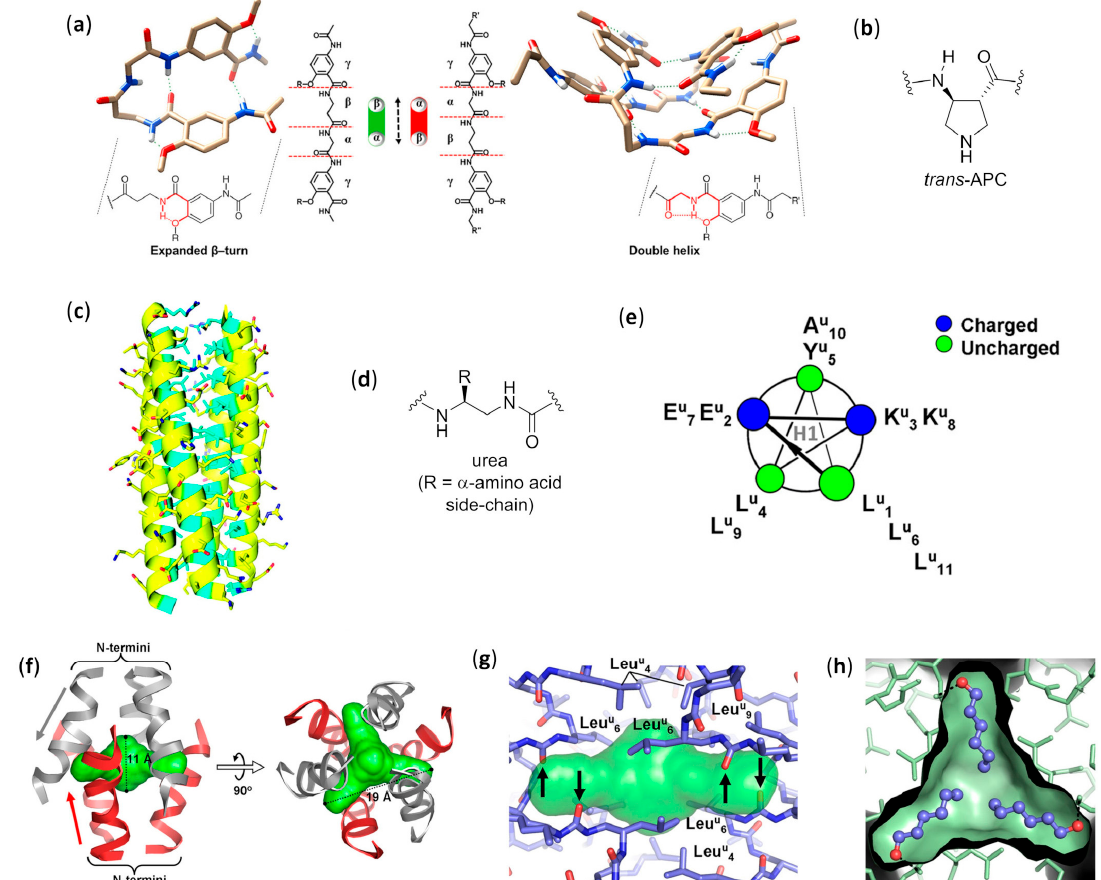
Figure 19. ( a ) Different behavior of γβαγ and γαβγ foldamers (adapted with permission from Ref. [207]); ( b ) Structure of trans -APC ( trans - β -aminopyrrolidinecarboxylic acid) (Refs. [2,4,5,8]); ( c ) Tetrameric bundle of a foldamer bearing only hydrophobic β 3 -amino acids at a and d positions (yellow: α -residues; cyan: β -residues) (adapted with permission from Ref. [213]); ( d ) Structure of generic urea monomers with proteinaceous side chains (Refs. [8,217–220]); ( e ) Helical-wheel representation of urea Leu u -Glu u -Lys u -Leu u -Tyr u -Leu u -Glu u -Lys u -Leu u -Ala u -Leu u (L u = Leu u , E u = Glu u , K u = Lys u , Y u = Tyr u , A u = Ala u ) (reprinted with permission from Ref. [220]); ( f ) Hexameric bundle and hydrophobic cavity (green) of urea in panel e (3-fold symmetry, the gray and red arrows indicate the N- to C-terminus direction for the three molecules belonging to the upper and lower portions, respectively) (reprinted with permission from Ref. [220]); ( g ) Detail of the hydrophobic cavity (green) within the crystal structure in panel ( f ) (black arrows indicate the carbonyl groups of Leu u6 residues, which act as hydrogen bonding acceptors) (adapted with permission from Ref. [220]); ( h ) Detail of the hydrophobic cavity of the same oligourea in the crystal structure with three 1-hexanol molecules bound to carbonyl groups of Leu u6 residues within the hydrophobic cavity (hydrogen bonds are shown as black dotted lines) (adapted with permission from Ref. [220]).